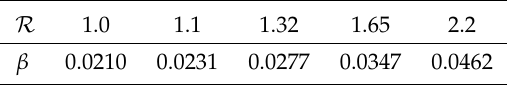
Table 4. Baseline transmission rates from NGM computation.